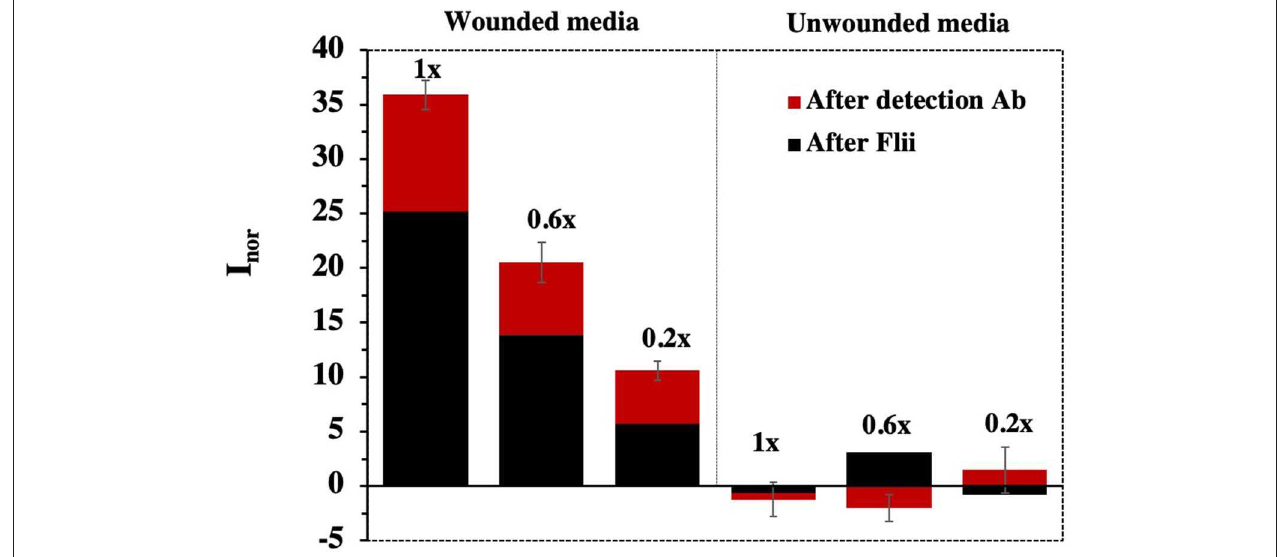
FIGURE 5 | Sensing response for concentrated wounded HaCat media containing Flii protein obtained using biosensors fabricated with NAA membranes of 65nm pore diameter. Error bars were calculated from three separate experiments.